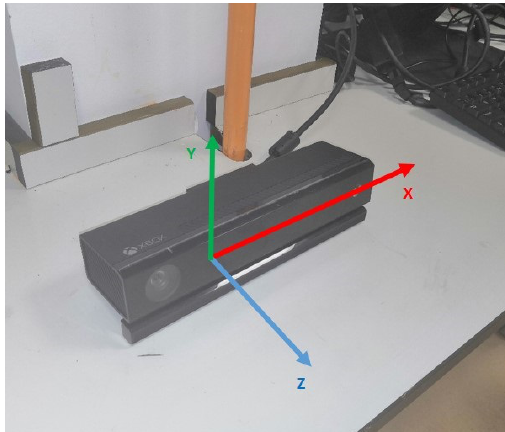
Figure 4. Illustration of the origin of the Kinect v2’s camera space. It is the same as its depth sensor